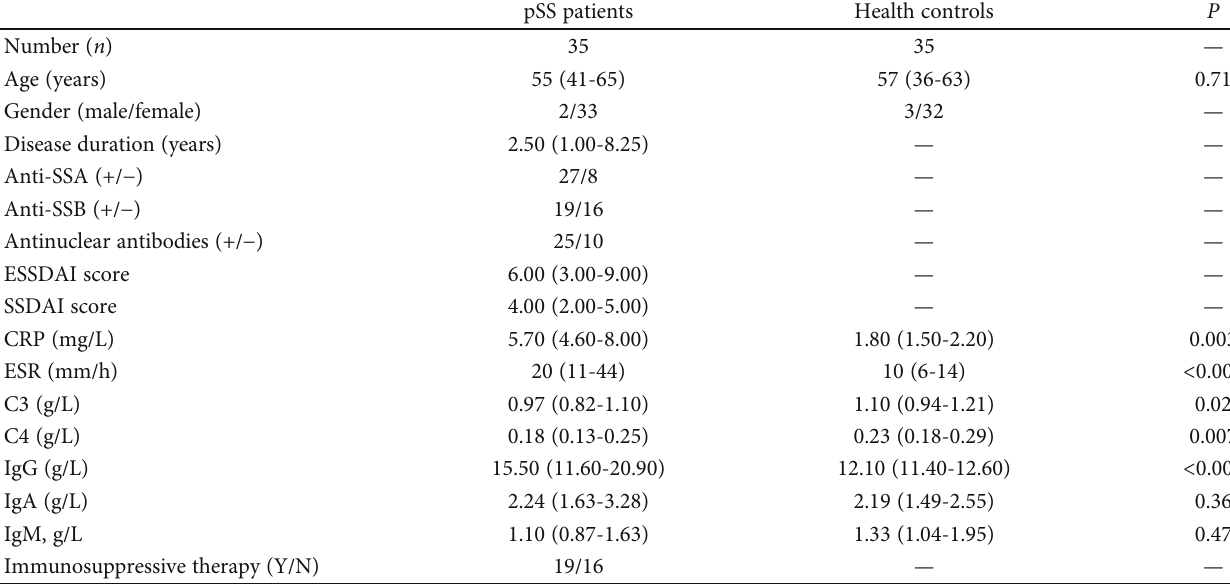
Table 1: Characteristics of study